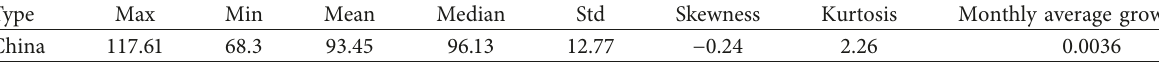
Table 1: The simple descriptive statistics of HPI in Chinese overall real estate market.